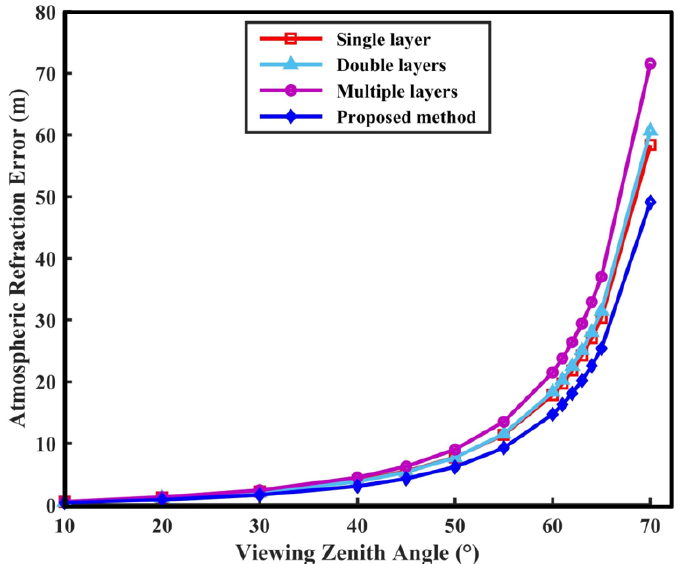
Figure 6. Simulation results of the atmospheric refraction errors of different atmospheric refraction correction methods. The red line, light blue line, purple line, and dark blue line represent the atmospheric refraction error of the single-layer method, the double-layer method, the multi-layer method, and the proposed SARCM with different viewing zenith angles, respectively.